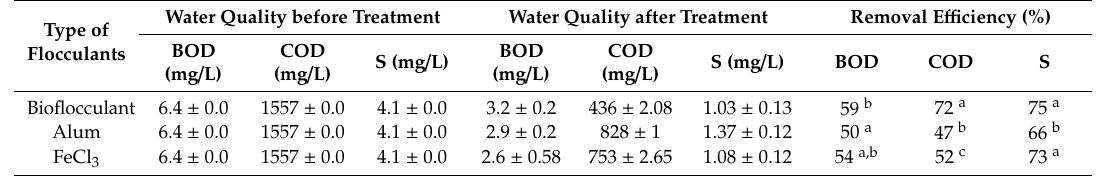
Table 5. Removal e ffi ciency of bioflocculant in comparison to chemical